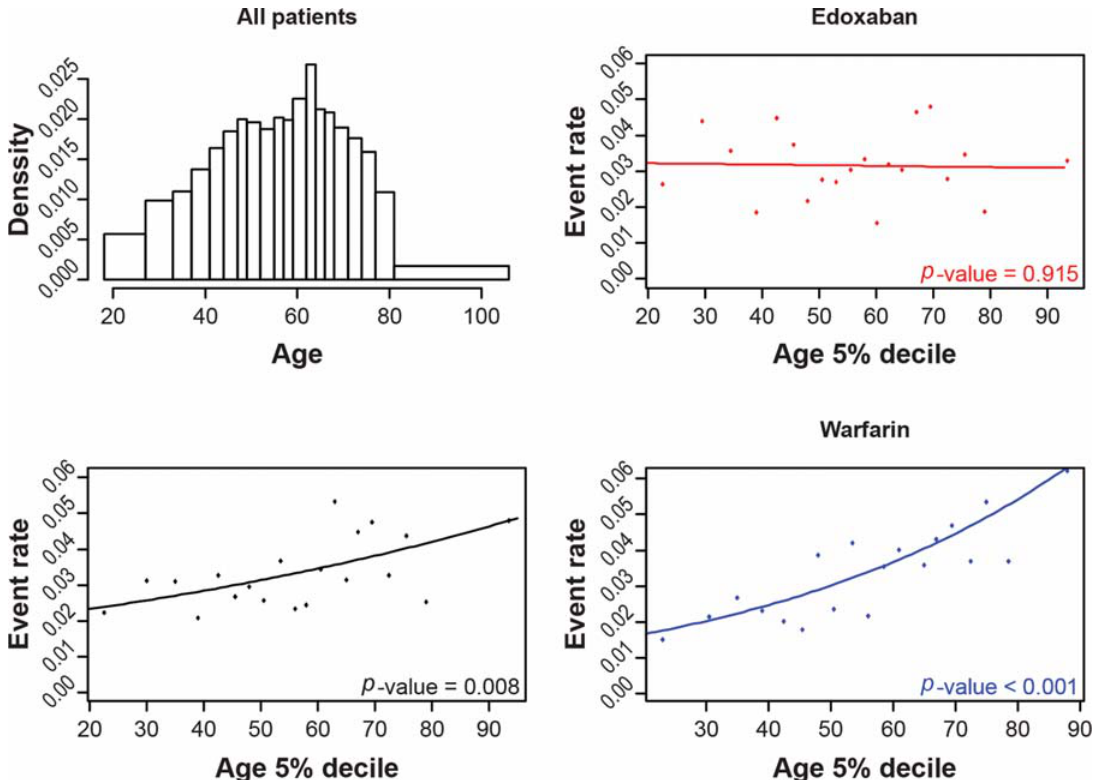
Fig. 1 The distribution of age and the relationship between VTE recurrence and age, by treatment arm. VTE, venous thromboembolism. Note: The top-left quadrant in this fi gure shows the age distribution, the bottom-left quadrant shows the relationship between the incidence of recurrent VTE and age in all patients, and the two graphs on the right-hand side show recurrent VTE according to treatment.